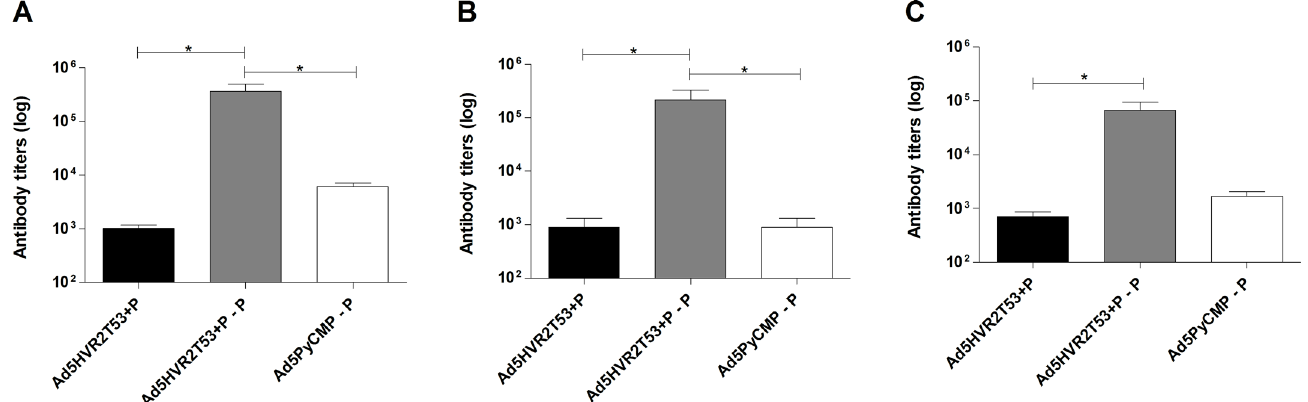
Fig 2. Antibody Responses induced by the vaccination regimens including Ad5HVR2 modified vectors. CB6F1/J (n = 5 per group) mice were primed with 10 7 v.p. of Ad5HVR2T53 co-administered (+) with PyCMP a multistage Plasmodium yoelii protein vaccine (P) that targets a hepatic stage antigen the Circumsporozoite Protein (CSP) and a blood stage antigen the Merozoite Surface Protein 1 (MSP-1), one of the groups received a boosting immunization (-) with the protein alone. A third group received an immunization with Ad5 encoding the multistage protein as a transgene (Ad5 PyCMP ) as a prime and a boosting immunization with the multistage protein. Total IgG antibody titers 20 days after the final immunization are expressed as log against the recombinant protein (A) , MSP1 (B) and CSP (C) . The differences between the groups were analyzed by one-way ANOVA with a Bonferroni post-test, significant statistical differences between the groups are denoted by * (p < 0.05) and ** (p <